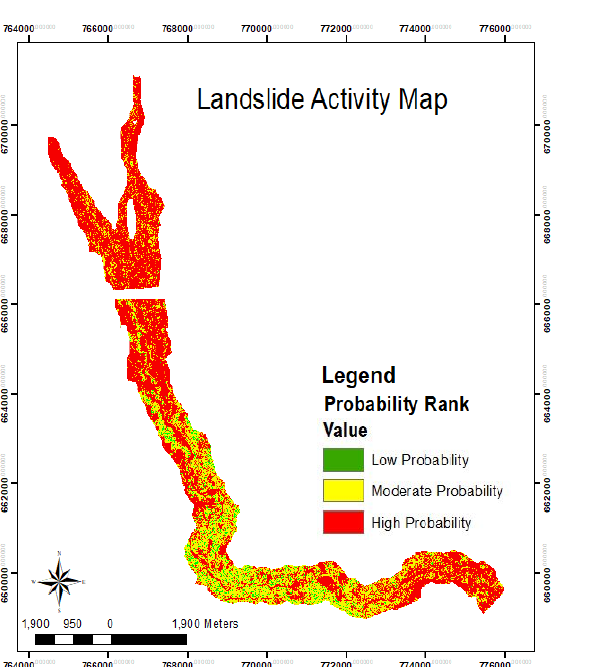
Figure 2. Active landslide probability map using FR method